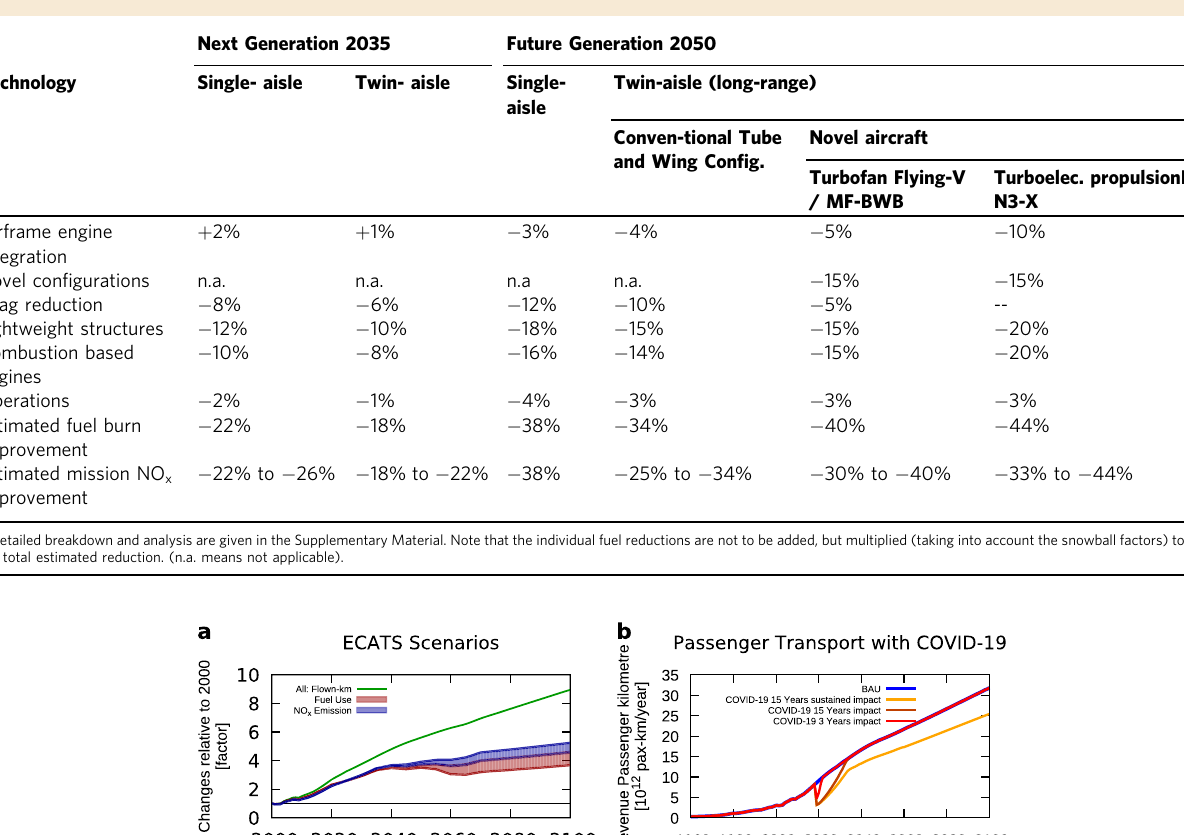
Table 3 Estimate of potential future fuel consumption reduction with respect to A320neo (single-aisle) and A350 (twin-aisle) and estimated mission NO x improvement (last